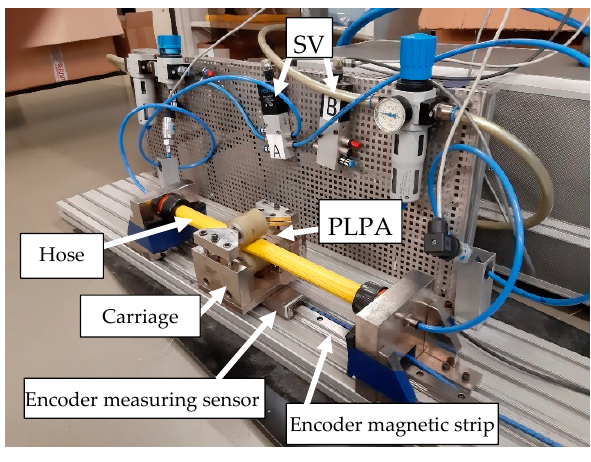
Figure 1. Experimental setup.